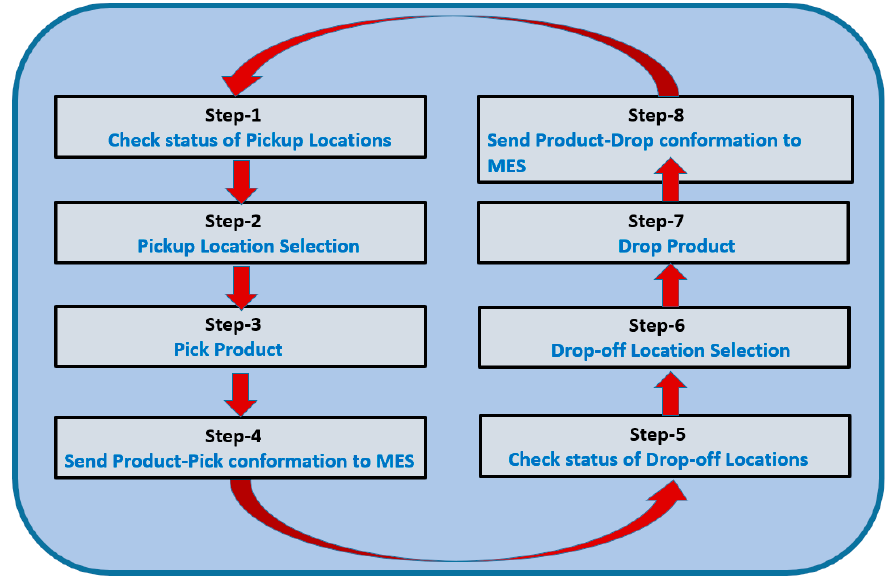
Figure 9. Steps of one complete cycle of scheduler operation.